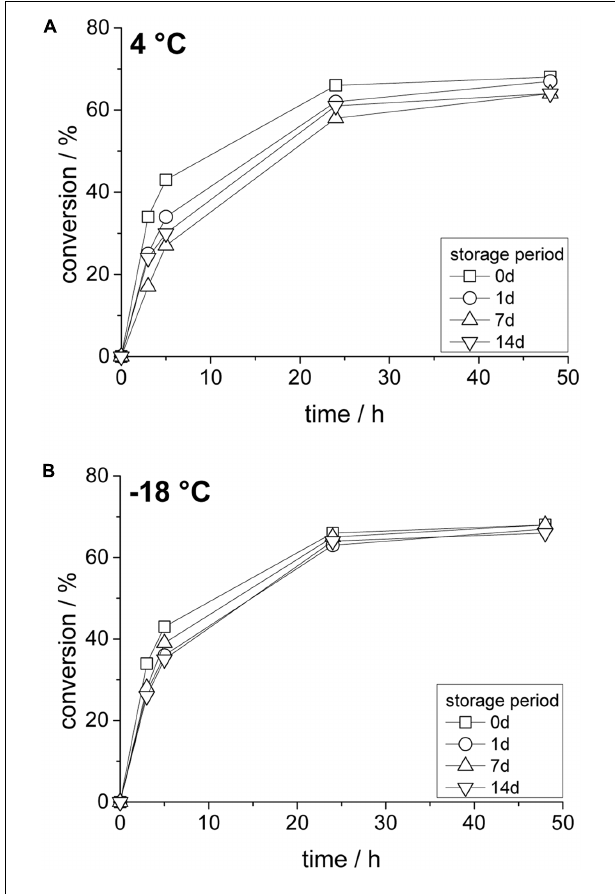
FIGURE 6 | Effect of storage temperature and time on compartmented Lk ADH with substrate-coupled cofactor regeneration; (A) storage at 4 ◦ C, (B) storage at –18 ◦ C. Reaction conditions: 10 mM substrate in 5 mL MTBE, 100 mM 2-propanol (in external solvent). Lactobacillus kefir , Lk ADH (see also above) and